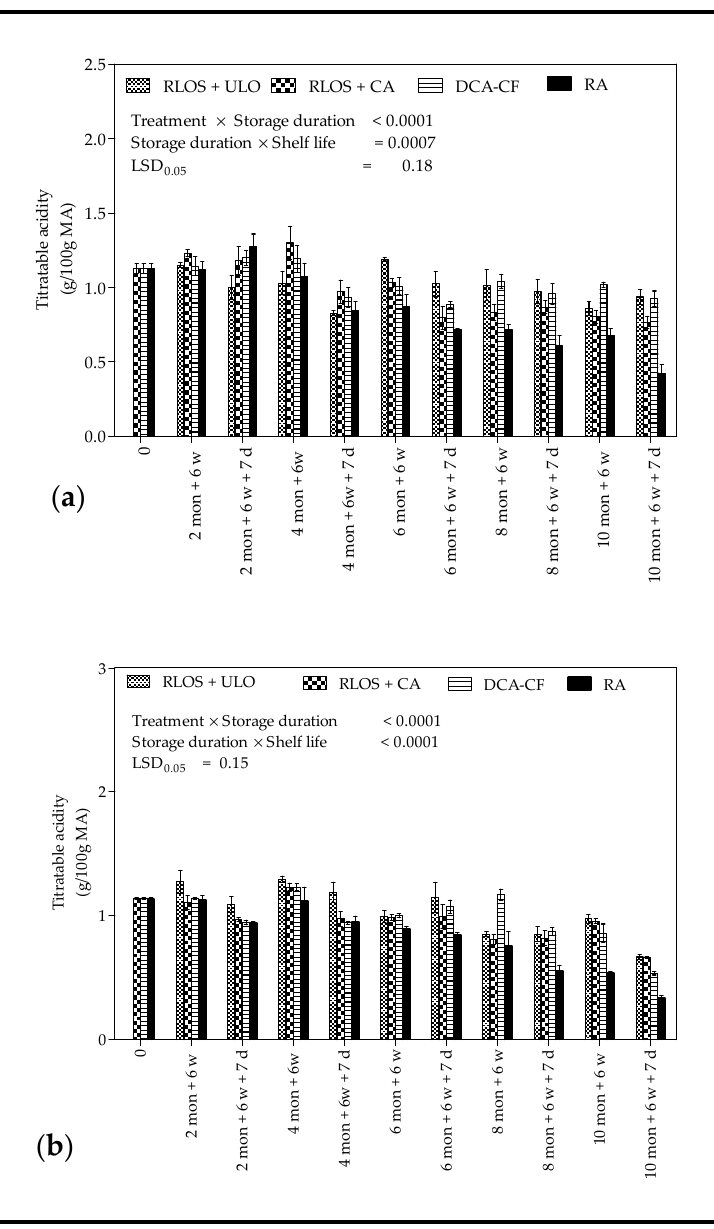
Figure 5. Titratable acidity (g/100 g MA) of ‘Granny Smith’ apples harvested in the 2015 ( a ) and 2016 ( b ) seasons at commercial maturity and stored for up to 10 months at 0 °C in various storage conditions, evaluated every two months followed by a 6 week simulated shipment and handling period, and at 7 days on the shelf (20 °C and 65% RH). Vertical bars represent the standard error (SE) of mean values of 3 replicates (1 replicate = 10 fruit). LSD 0.05 represents least significant difference ( p < 0.05). For storage duration, mon—months; w—weeks; and d—days. RLOS—repeated low oxygen stress; ULO—ultra-low oxygen; CA—controlled atmosphere; DCA-CF—dynamic controlled atmosphere-chlorophyll fluorescence; RA—regular atmosphere.